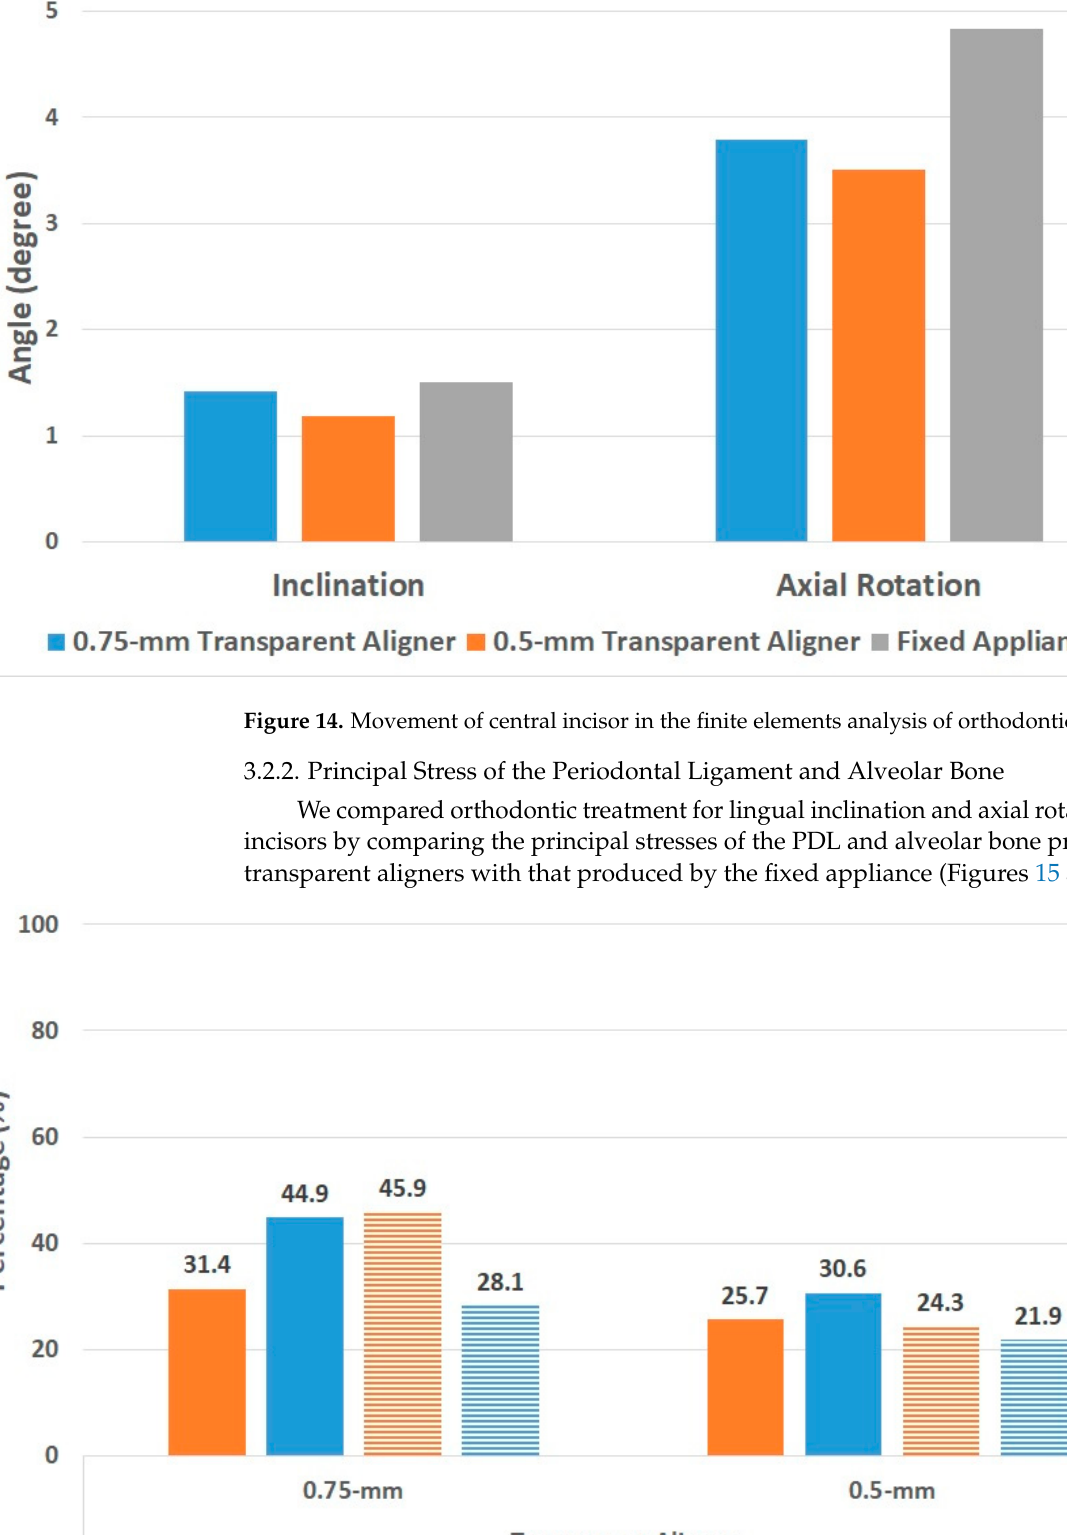
Figure 14. Movement of central incisor in the finite elements analysis of orthodontic treatment.